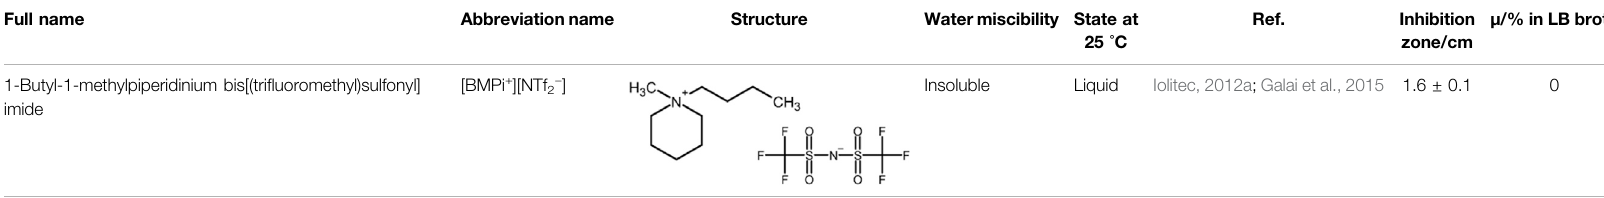
TABLE 4 | Piperidinium-based ionic liquids.